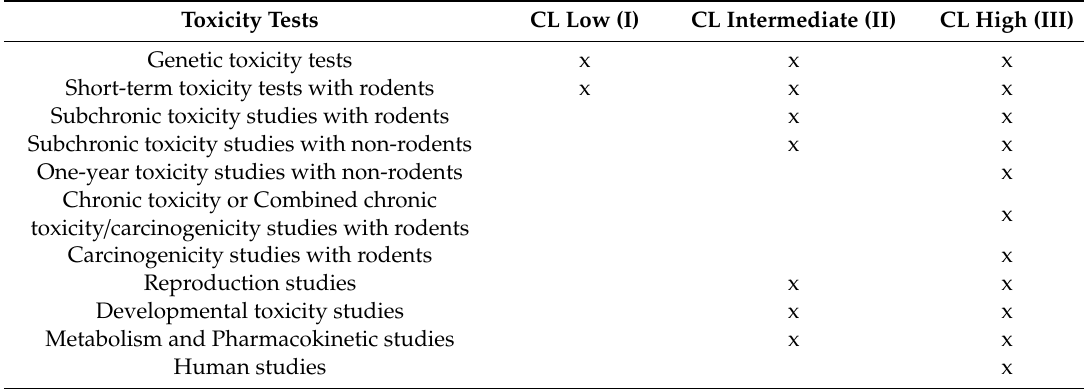
Table 2. Toxicity tests requested by the US Food and Drug Administration for safety evaluations of food